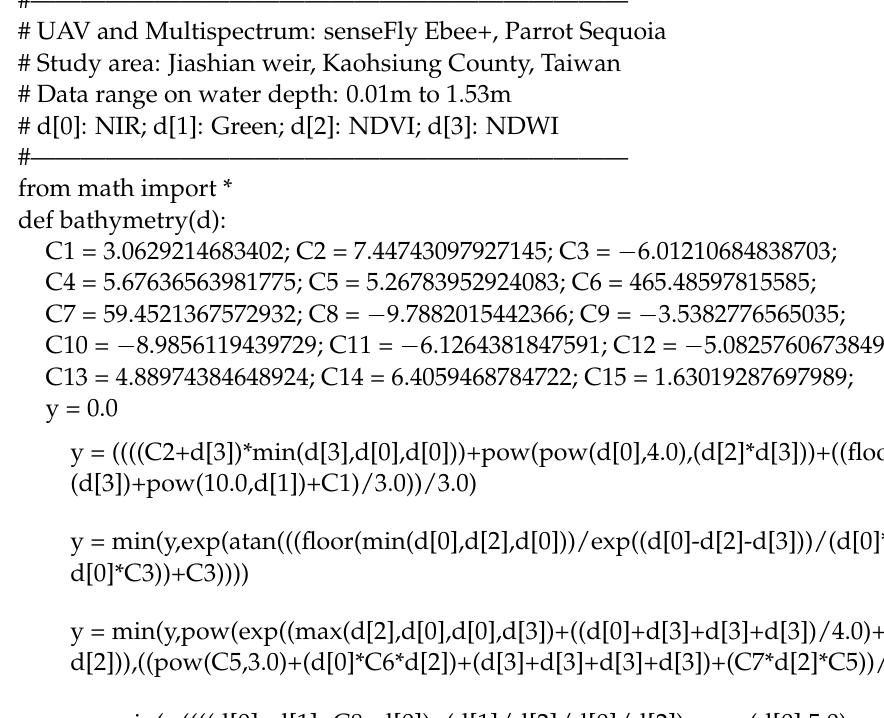
function, Sin is sine function, Ln is natural log function, and C1 to C15 is constants, which can be can be found in Appendix B.